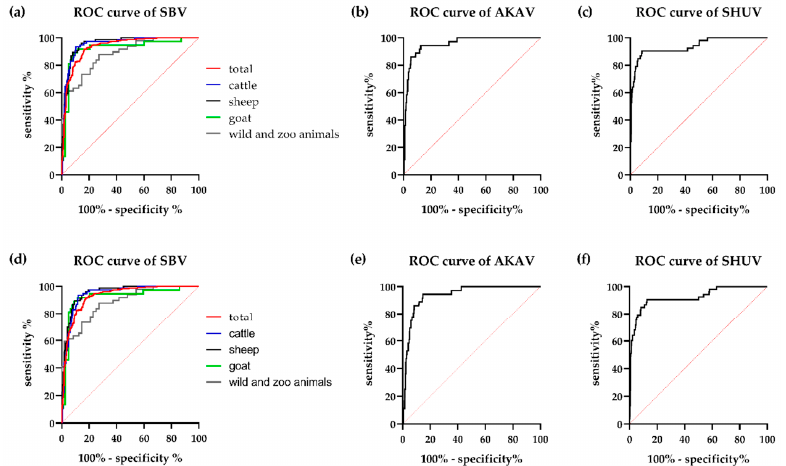
Figure 2. Receiver operating characteristic (ROC) analyses of the triplex SBV–AKAV–SHUV ELISA using 477 negative sera and 238 SBV antibody-positive sera, 36 sera displaying antibodies against AKAV and 53 SHUV seropositive samples. For the SBV assay ( a , d ), the ROC curves are shown separately for cattle (blue), sheep (black), goat (green) and wild and zoo animals (grey), the combined ROC curve that includes all species is depicted in red. The ROC analyses were performed using two different set-ups, for the first ( a – c ) only sera negative against all three simbuviruses were included as negative samples, while in the second approach ( d – f ) negative samples additionally include sera negative against the given antigen, but positive towards another Simbu serogroup virus. SBV, Schmallenberg virus; AKAV, Akabane virus; SHUV, Shuni virus. Using these cut-off values, overall diagnostic specificities of 84.56%, 94.68% and 89.39% and sensitivities of 89.08%, 69.44% and 84.91% were achieved for SBV, AKAV and SHUV, respectively. Taking in account differences between set-ups 1 and 2, only a limited impact of cross-reacting antibodies could be observed (Table 2). When comparing the diagnostic characteristics of the SBV test separately for each animal species included in this study, a higher sensitivity was observed when testing domestic ruminants (cattle, goat, sheep) in comparison to wild and zoo animals (Table 2). All sera were additionally tested by the gold-standard test SNT against all three viruses and the measured neutralizing titers were compared to the ELISA values. Overall, the proportion of false-negative ELISA results was higher for samples with low neutralizing titers (<1/80), an effect most prominent for previously AKAV-infected individuals or SBV-antibody-positive wildlife and zoo animals (Figure 3).